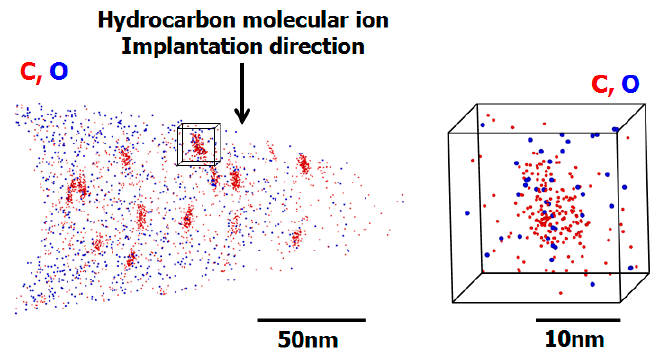
Figure 16. Atom probe tomography map of hydrocarbon–molecular–ion implantation projection range after CMOS image sensor fabrication process [36].